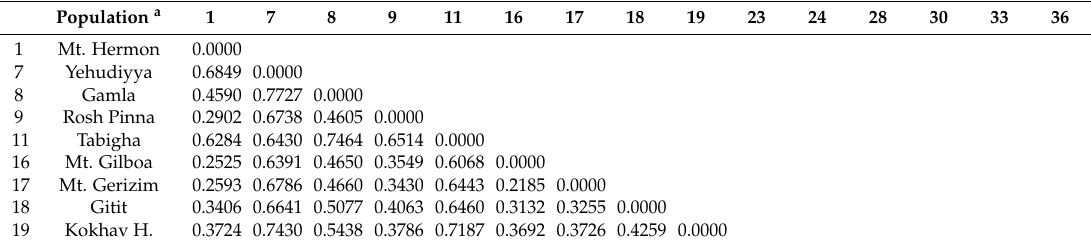
Table 4. Genetic distances as pair-wise comparisons between the 15 WEW